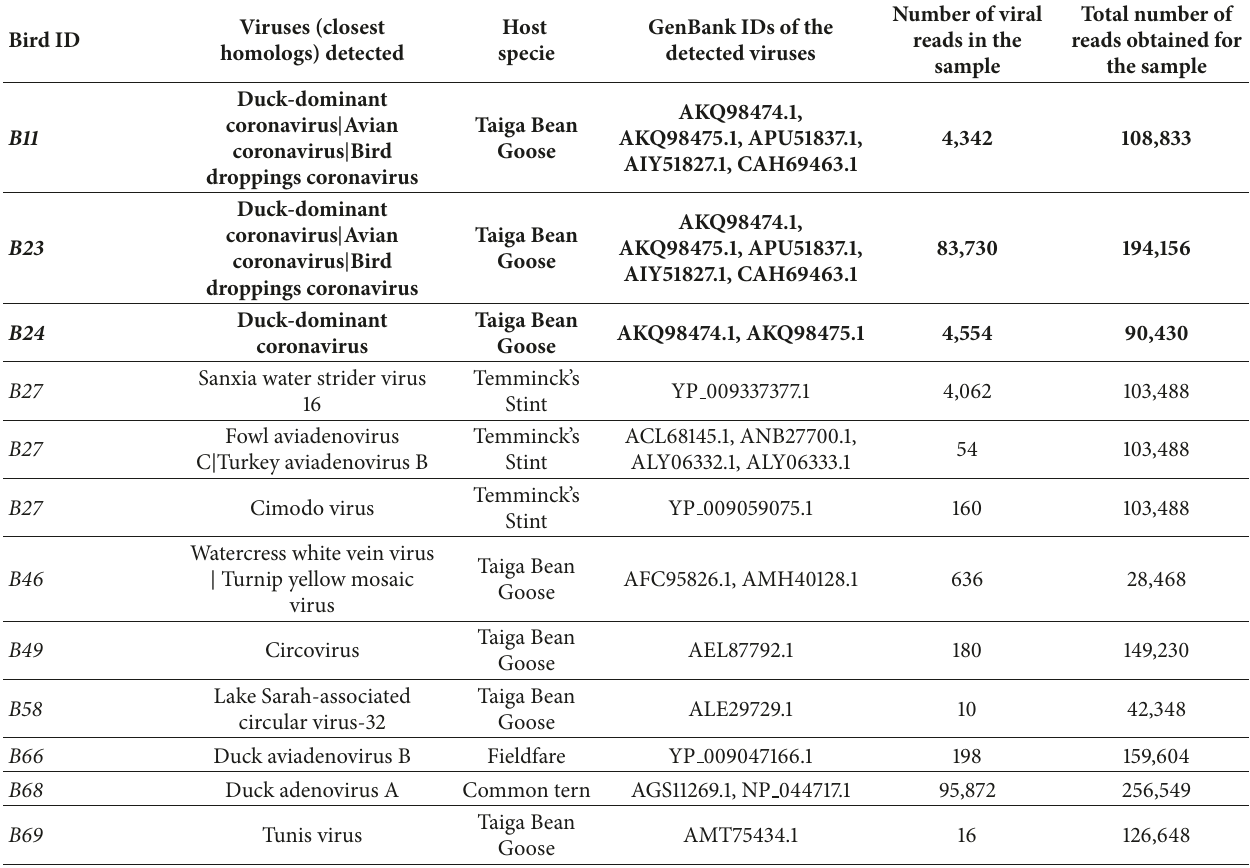
Table 3: Results of the bird samples sequencing with prior enrichment using the primers panel. The number of viral reads and total number of reads per corresponding sample are shown. For three samples ( B11 , B23 , and B24, highlighted in bold) there was a specific primer pair in the panel present for the amplification of the detected genus. Closest viral homologs names and their GenBank IDs are shown.